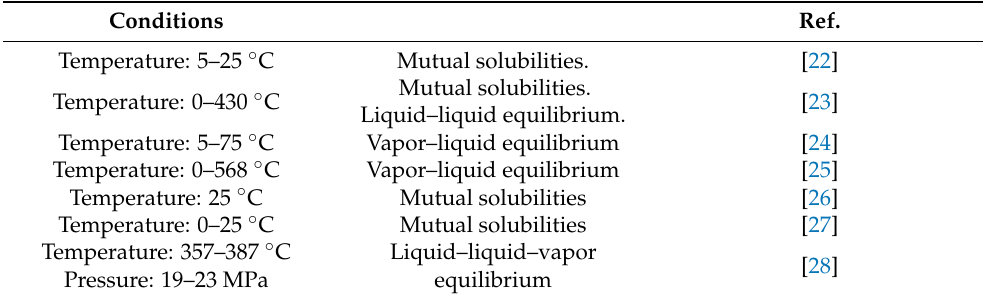
Table 2. Results in the Technical Literature Related to Experiments with Water/n-Octane Mixtures.